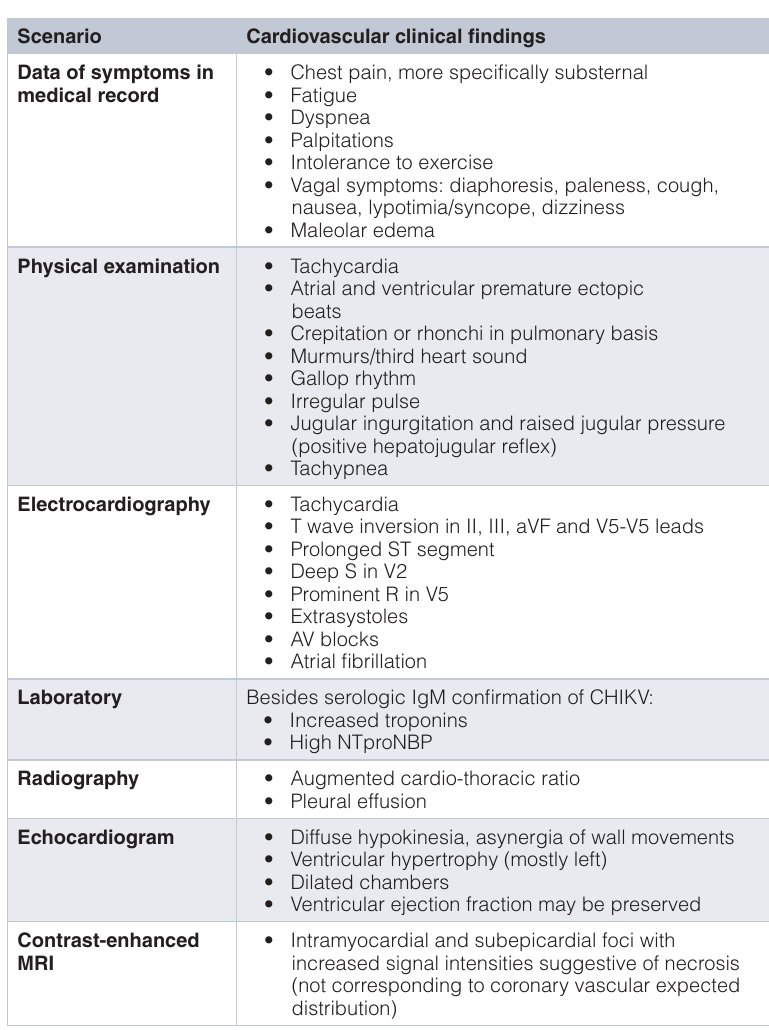
Table 3. Key clinical findings during CHIKV infection that suggest cardiac viral compromise 12,19–22 . AV: Atrioventricular. NTproBNP: N-terminal pro-Brain